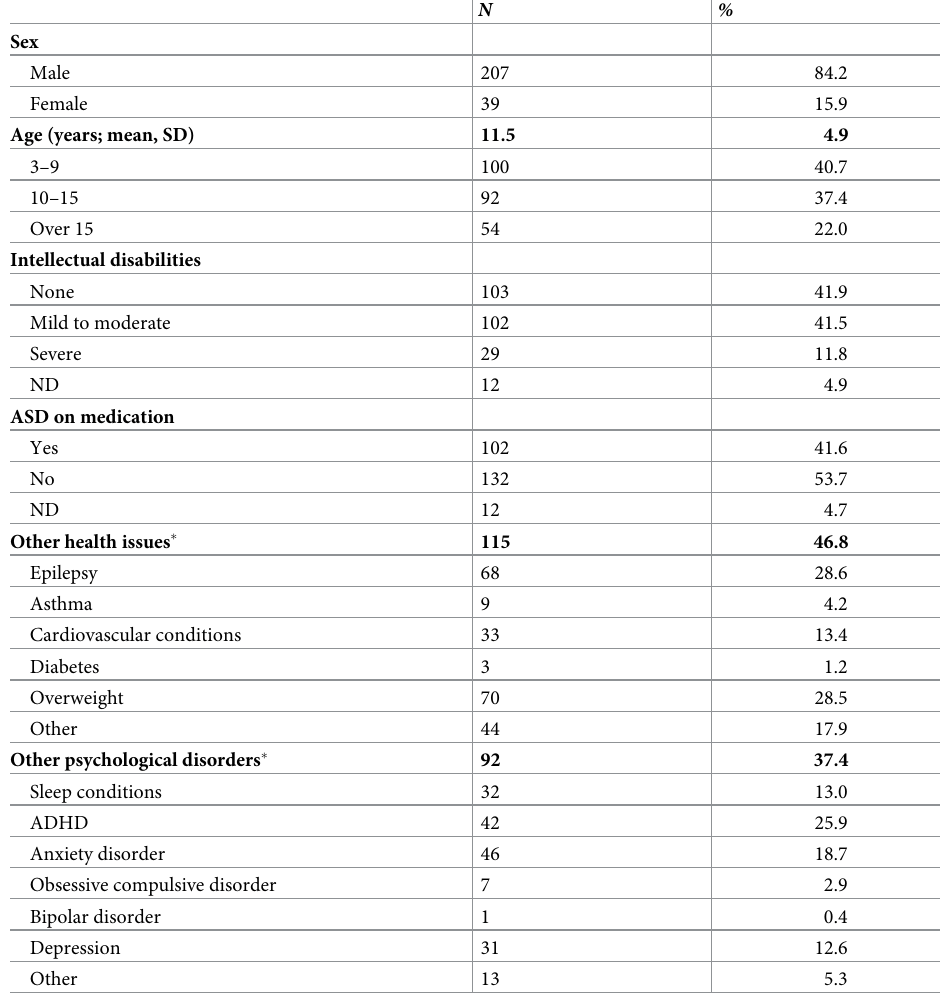
Table 1. Participant demographic characteristics and clinical information ( N =